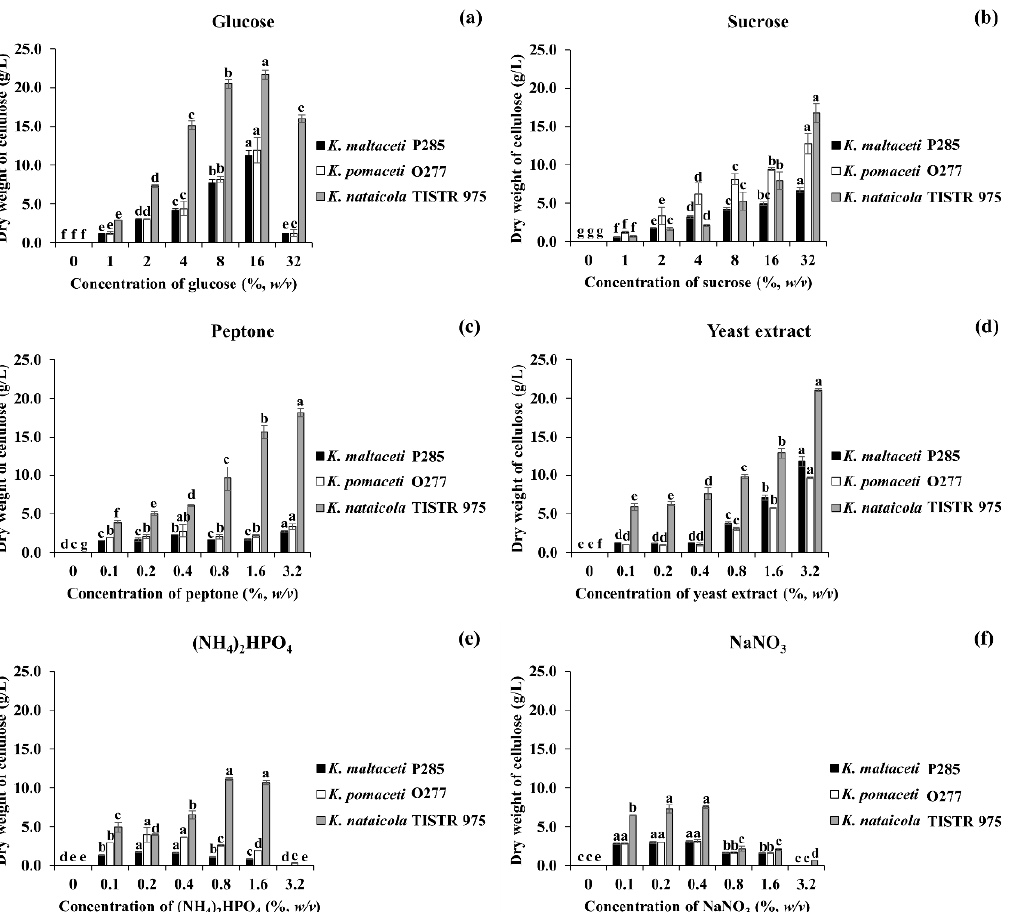
Figure 3. Dry mass of bacterial cellulose obtained from modified MSM with various concentrations of carbon, glucose ( a ); sucrose ( b ); and nitrogen sources, peptone ( c ); yeast extract ( d ); (NH 4 ) 2 HPO 4 ( e ) ; and NaNO 3 ( f ) produced by K. maltaceti P285 and K. pomaceti O277. The K. nataicola TISTR 975 was used as a control. Data expressed mean ± standard deviation of three independent experiments. The difference letters were considered statistically significant ( p < 0.05) for each bacterial strain.